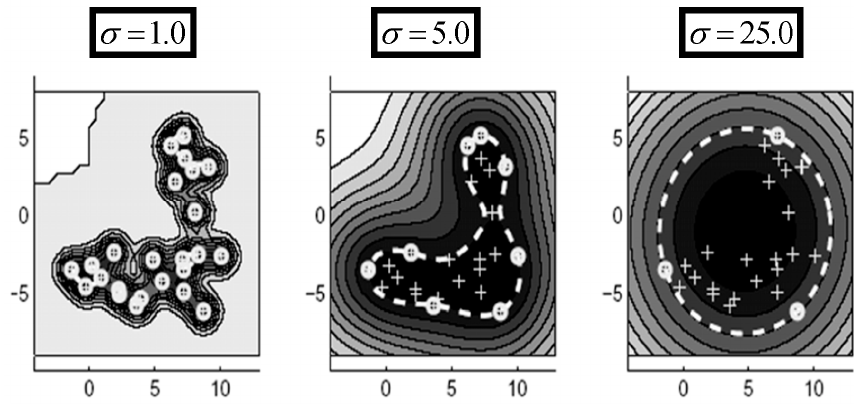
Figure 3. The influence of the RBF spreading parameter on the behaviour of the one class SVM [20].